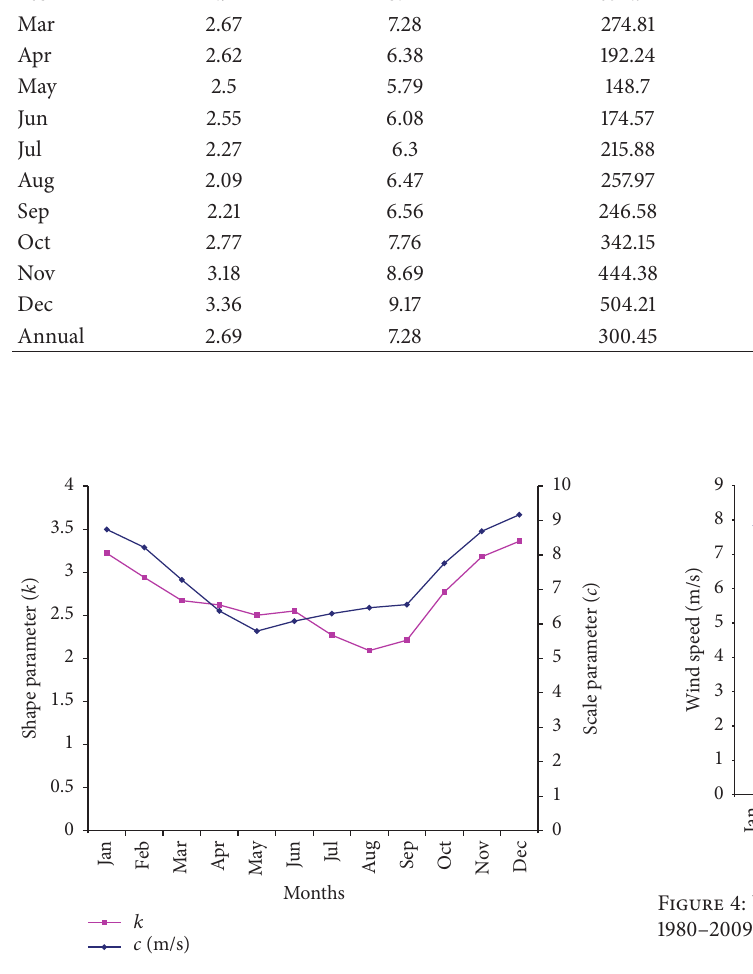
Figure 3: Values of monthly mean shape ( 𝑘 ) and scale ( 𝑐 ) parame- ters for the period 1980–2009 in the ECS, unit: 𝑘 (dimensionless), 𝑐 (m/s).